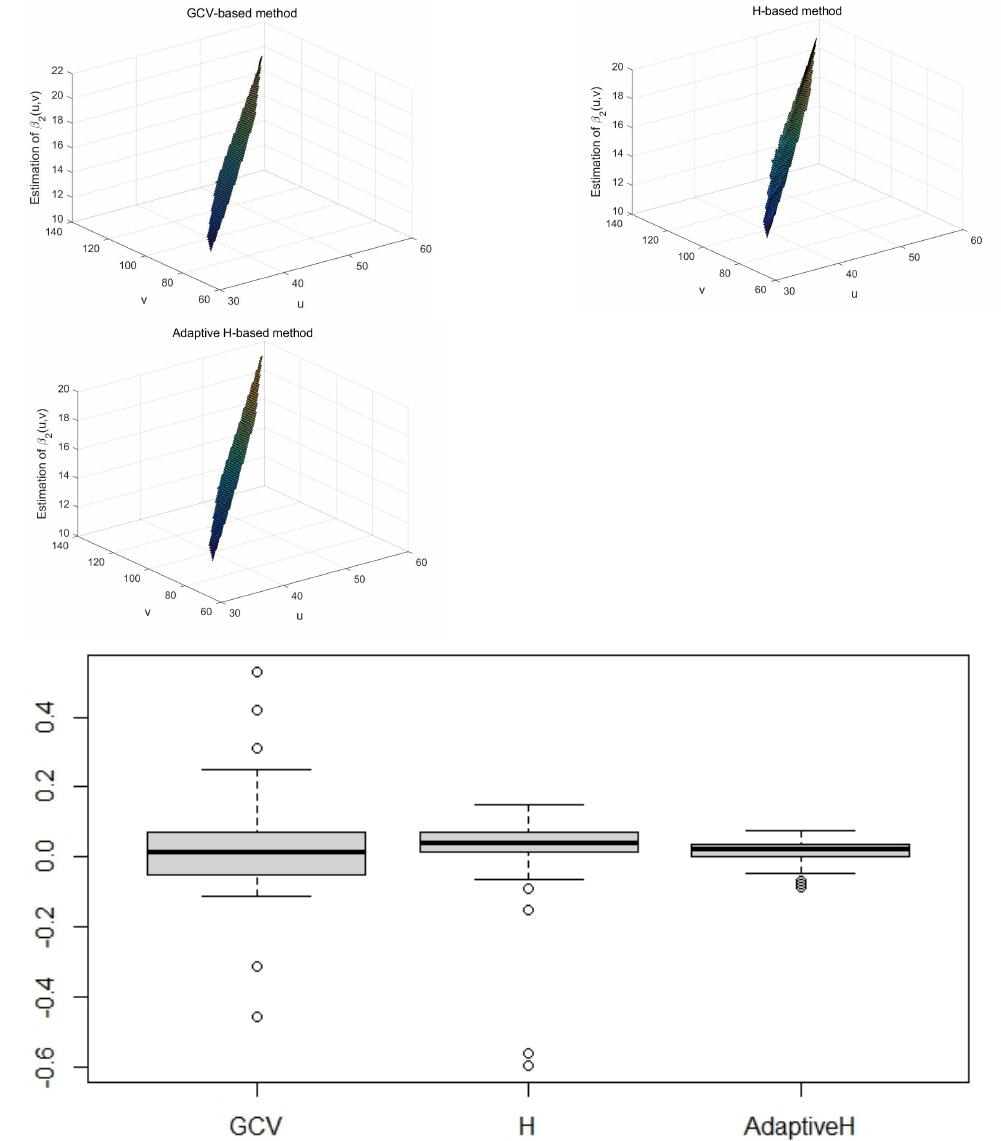
Figure 3. The estimated surface of β 2 ( u , v ) ( top row ) and residuals boxplots ( bottom row ) with the GCV − based method ( left panel ), the bandwidth matrix H ( middle panel ) and the adaptive bandwidth matrix H method ( right panel